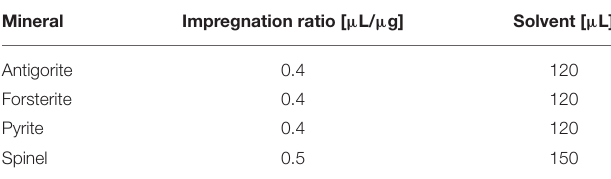
TABLE 2 | Impregnation ratio estimated values for four mineral